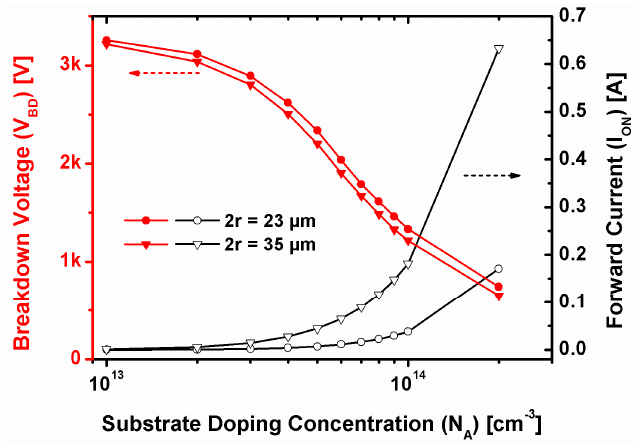
Figure 4. Simulated inner-cell breakdown voltage, V BD|CELL , ( red curves ) and forward current at saturation, I ON , ( black curves ) as a function of the substrate doping concentration, N A , for a given V-JFET design with two different cell diameters (2 r = 23 and 35 µm), and a total active area A = 5 × 5 mm 2 .